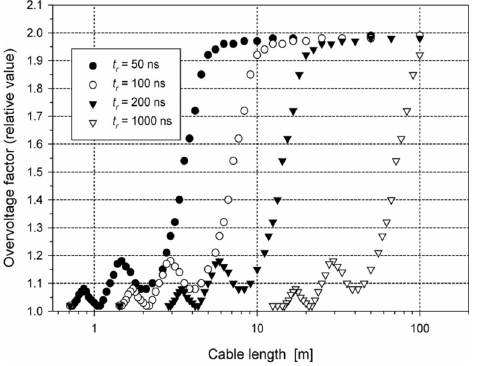
Figure 4. Overvoltage factor depending on cable length and rise time.